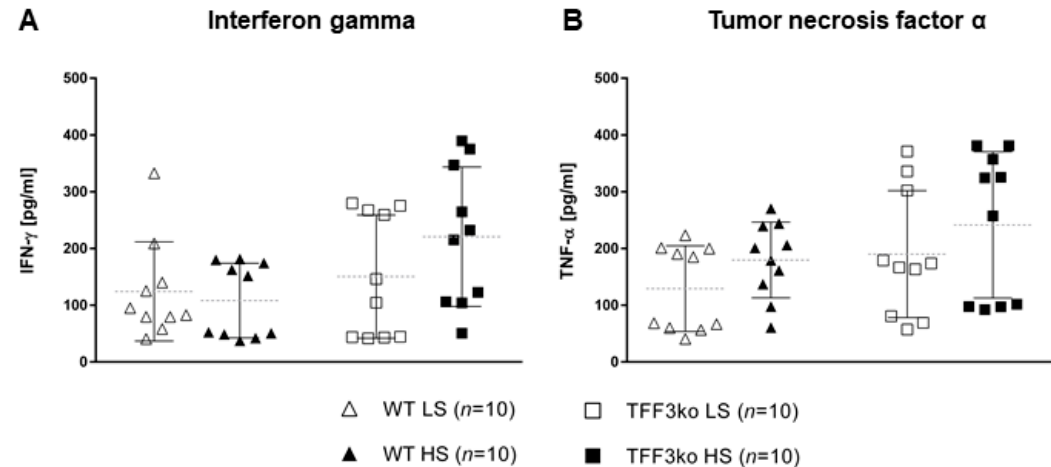
Figure 2. The serum concentrations of inflammatory markers IFN- γ ( A ) and TNF- α ( B ) in Tff3 - deficient mice and their respective wild-type controls exposed to a 7-day high-salt diet. WT LS—wild-type (C57BL/6N) mice on a low-salt diet; WT LS—wild-type (C57BL/6N) mice on a high-salt diet; TFF3ko LS— Tff3 knock-out mice on a low-salt diet; TFF3ko HS— Tff3 knock-out mice on a high-salt diet; IFN-γ—interferon gamma; TNF-α—tumor necrosis factor alpha. Data are presented as mean ± SD and were analyzed by one-way ANOVA or Kruskal– Wallis test where appropriate.